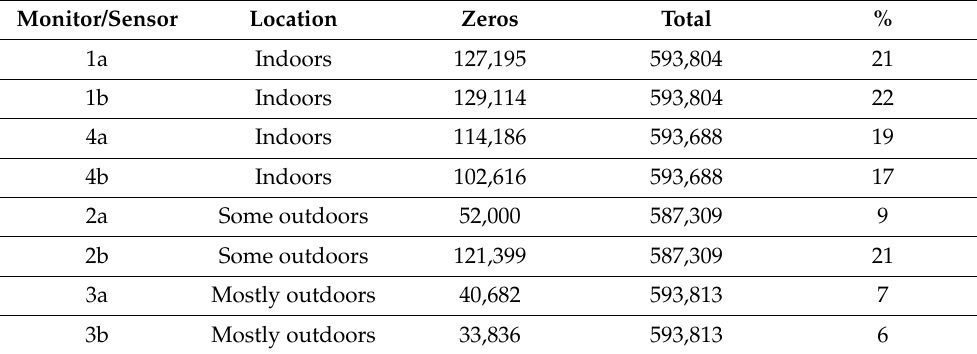
Table 3. Number of zeros reported by CF1 (and CF_ATM) and percentage of total measurements.